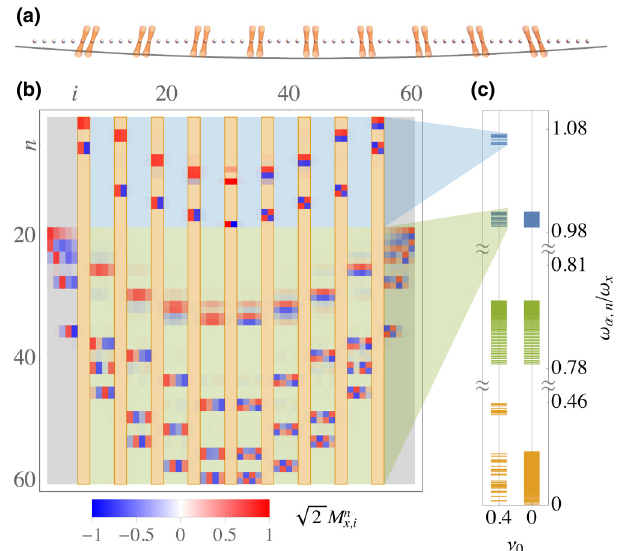
FIG. 2. (a) N = 60 ions in an array of optical tweezers, which subdivides the chain into groups of p = 6 six ions. The first and last five buffer ions are not used as qubits. (b) Mode matrix for transverse x modes. Orange and gray shading indi- M n x , i cates pinned and buffer ions, respectively. Blue shading marks modes that are superpositions of localized COM and stretch modes of pairs of pinned ions. (c) Phonon-mode spectrum for = 0.4 and, for comparison, without tweezers, i.e., for ν ν 0 Transverse x and y modes and longitudinal z modes are shown, respectively, in blue, green, and orange. We assume that the ratio of transverse trapping frequencies is given by ω y /ω x = 0.8.